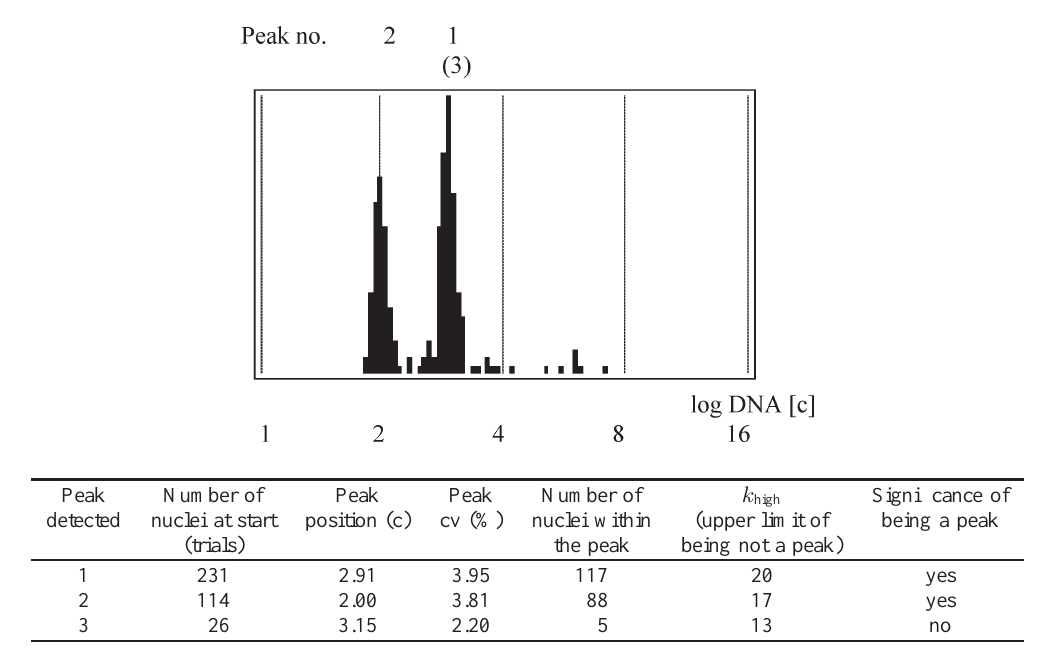
Fig. 3. DNA histogram of a breast cancer with obviously three “spikes”. Two of them are defined statistically as peaks. The details of the statistical figures are given below the